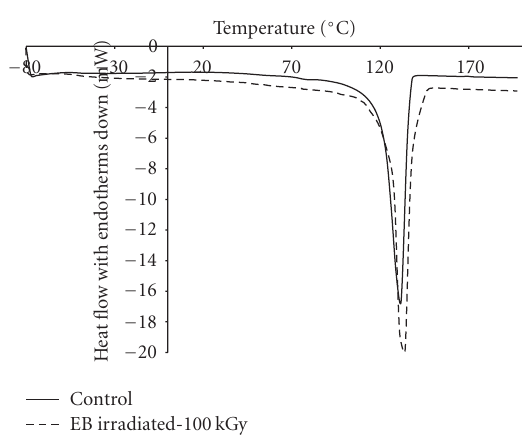
Figure 2: Melting endotherms of nanocomposites at 4vol% clay loading for control and EB-irradiated systems.